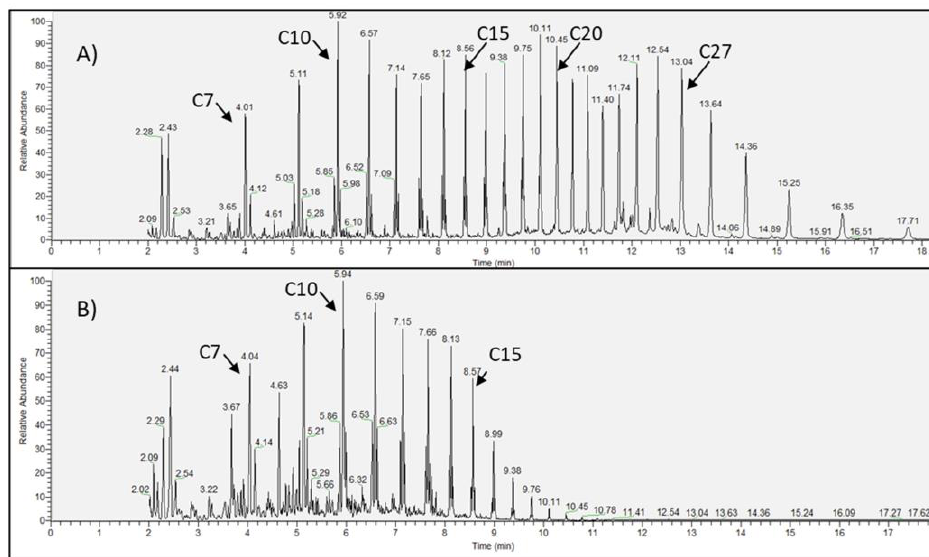
Figure 4. Chromatographs for ( A ) raw pyrolysis oil and ( B ) distilled pyrolysis oil.